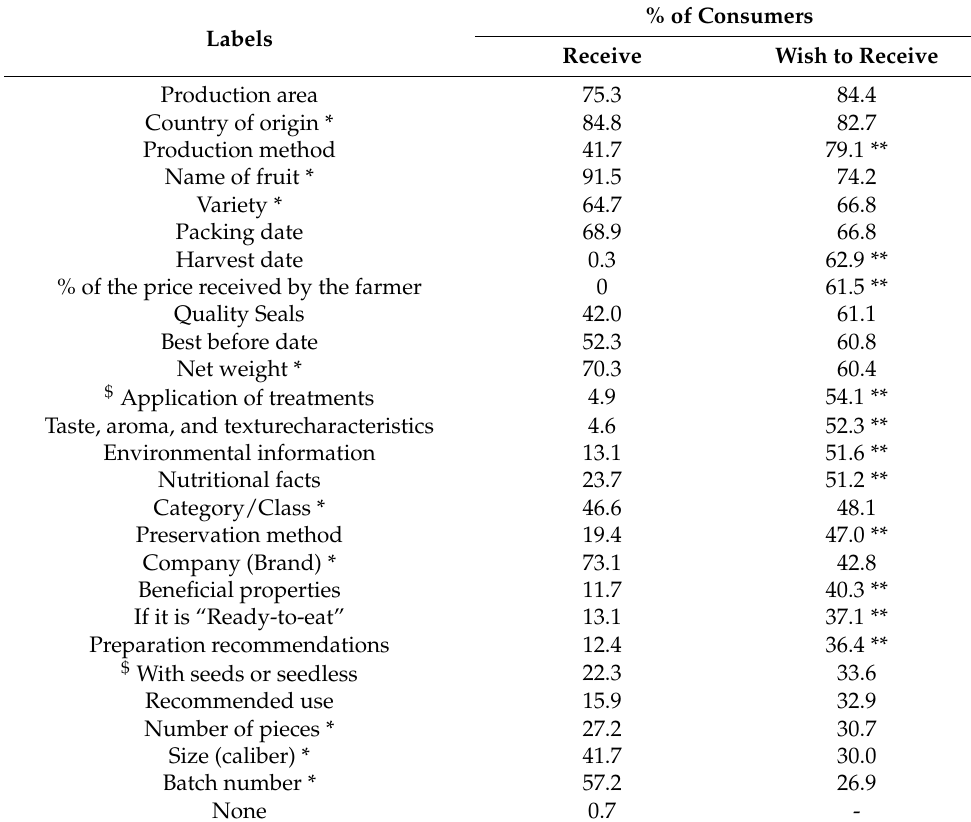
Table 1. Information gaps. Percentage of consumers who declared receiving different packaging labels when purchasing fruit vs. the percentage of those interested in each one. A 20% difference was established as the threshold to identify gaps, which are indicated with